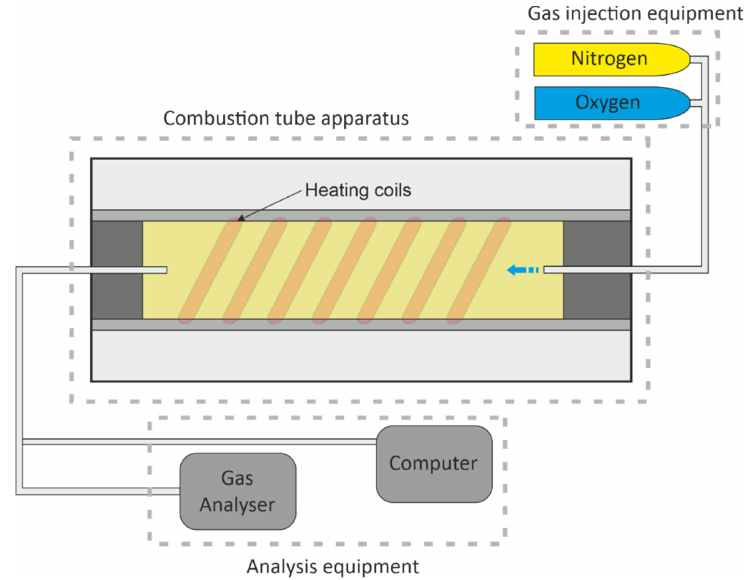
Figure 6. A simplified general setup diagram of combustion tube apparatus, with either rock or sand pack saturated with oil held in an insulated jacket, sometimes equipped with extra heating